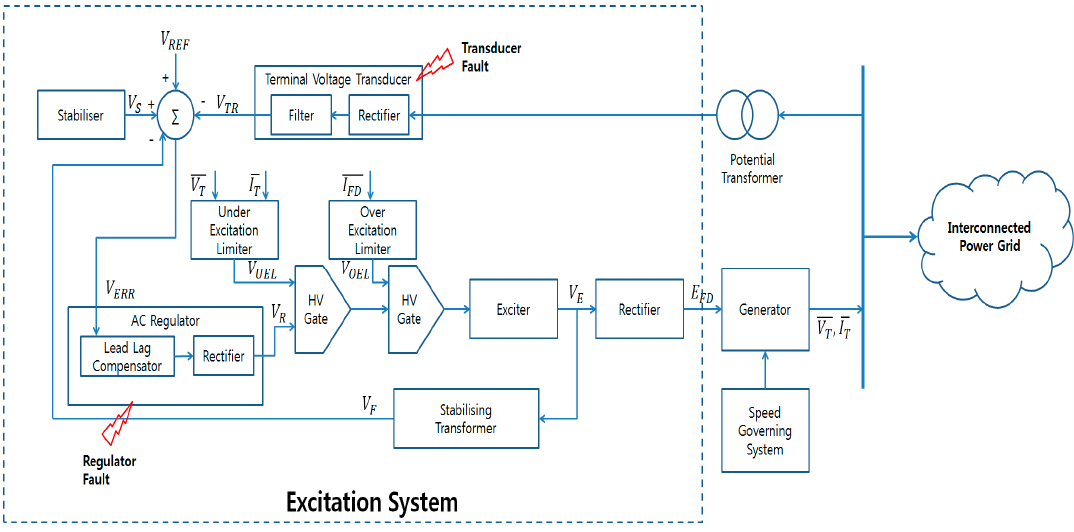
Figure 1. General block diagram of an excitation system.